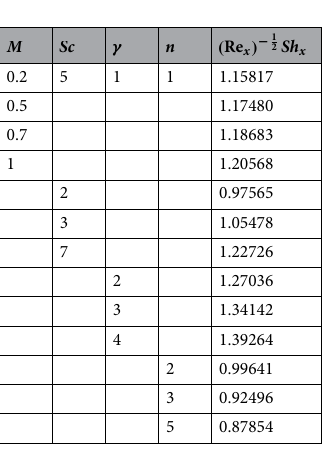
1 2 Sh x for numerous variations of Sc , M , and γ when Pr = 7, k = 0.5 and